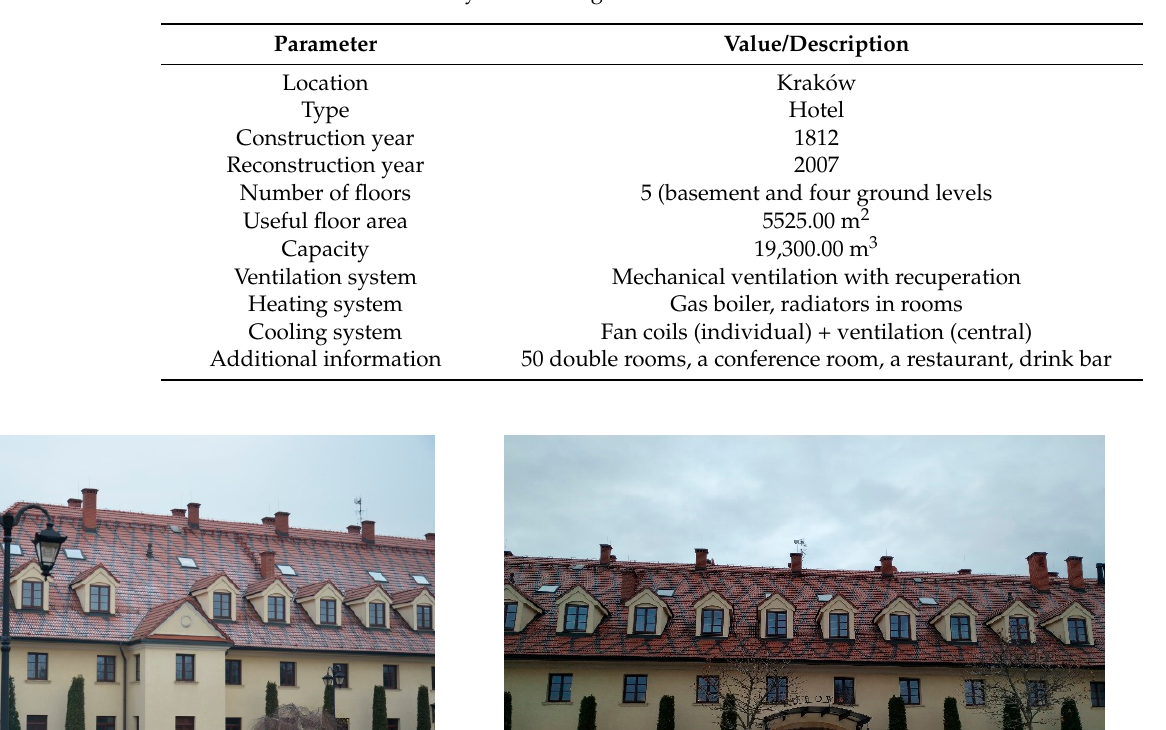
Figure 2. The framework of the case study. Table 1. Characteristics of analyzed building.